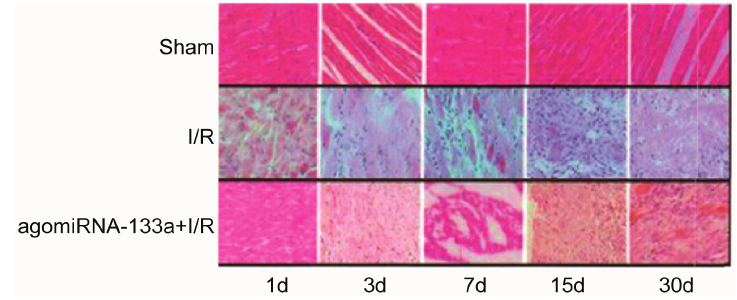
Figure 1. Myocardial cells of three groups at various time